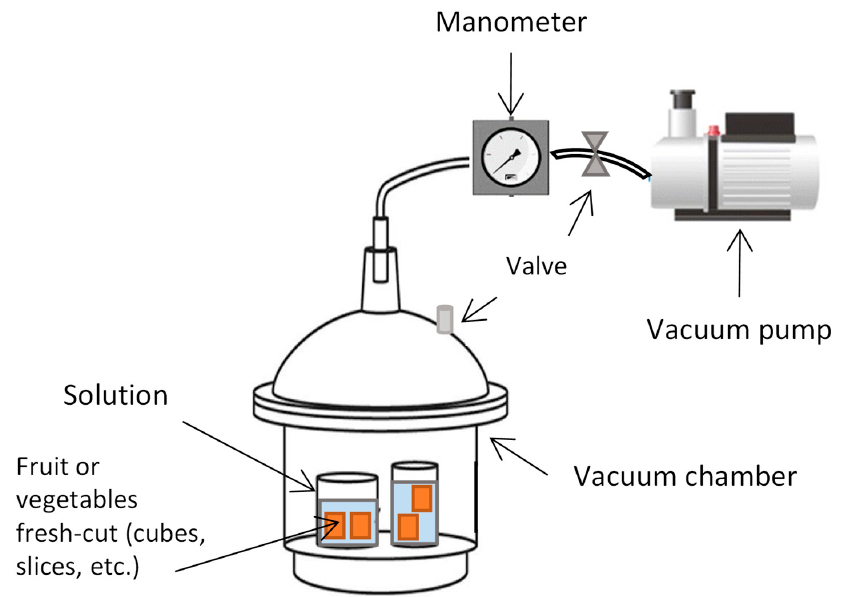
Figure 3. Schematic representation of the vacuum impregnation device, the arrows point at each system